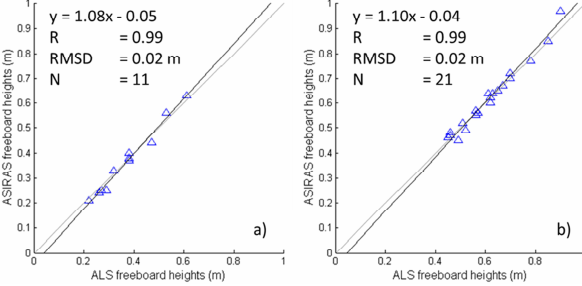
Figure 4. Scatterplot ASIRAS versus ALS total freeboard for the CryoVEx campaigns (see Fig. 1 for location) in 2008 (a) and 2011 (b)